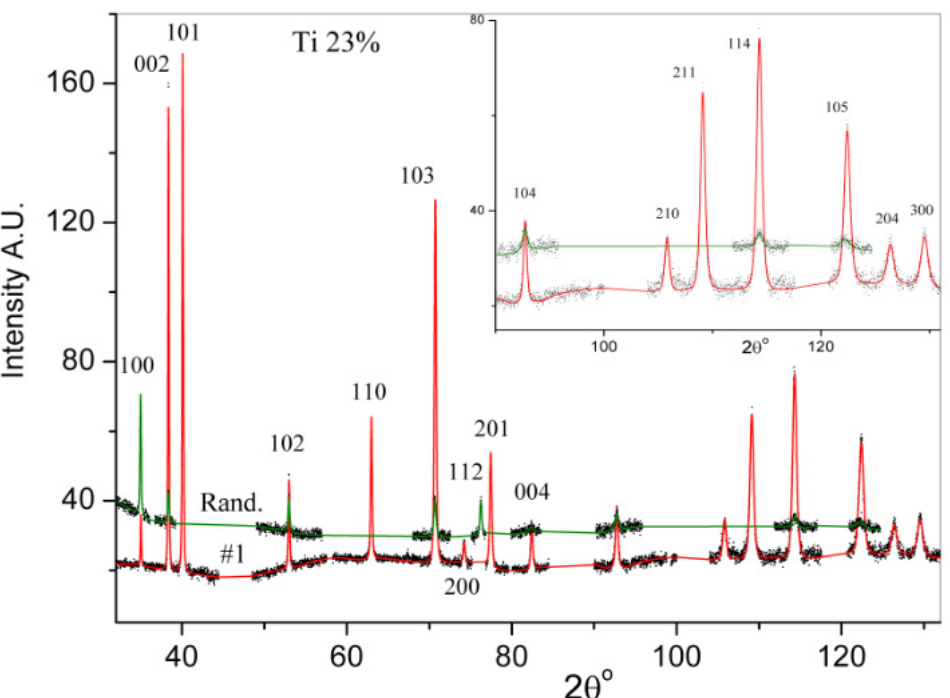
Figure 8. Texture-specific diffraction patterns (TSDPs) of the 23% tensile-deformed specimen for the major texture component #1 and random texture component. The black dots and solid lines are the measured data and the fitted pattern. The inset is the enlarged part of the high angle section of the pattern.